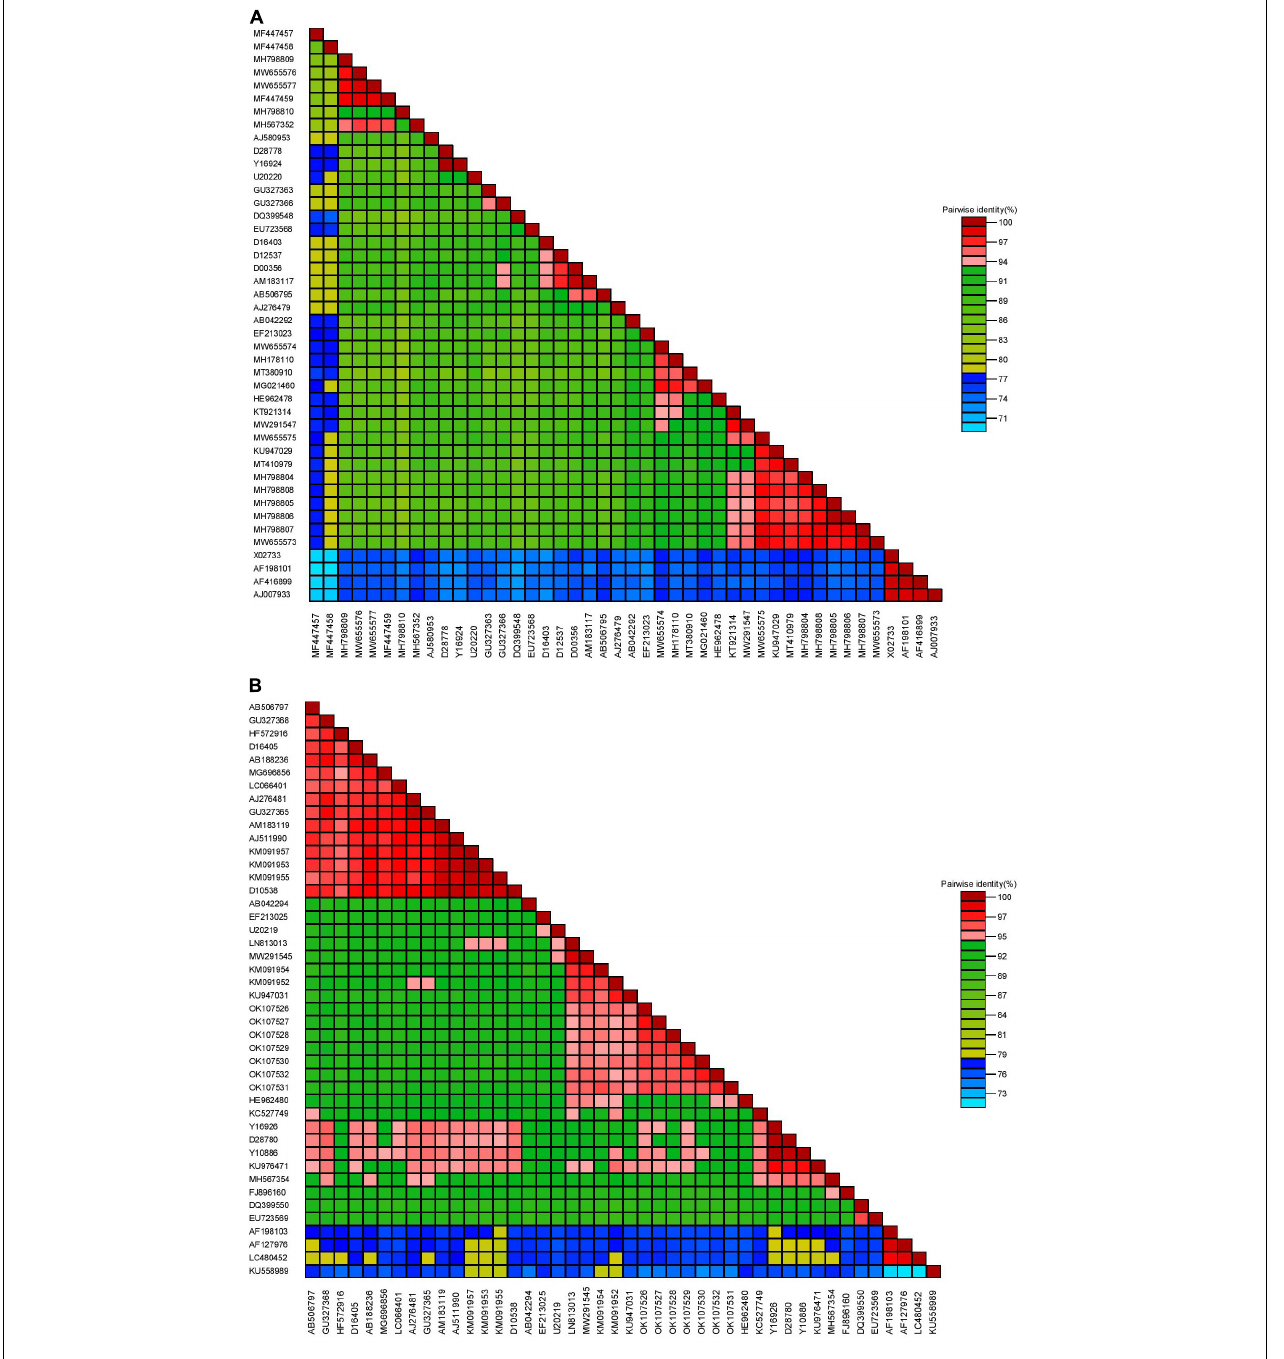
FIGURE 3 | Pairwise similarities of partial RNA1 (A) and complete coat protein (B) genomes from CMV in Nigeria with selected worldwide sequences (see Supplementary Table S1 for details of isolates used for analyses).